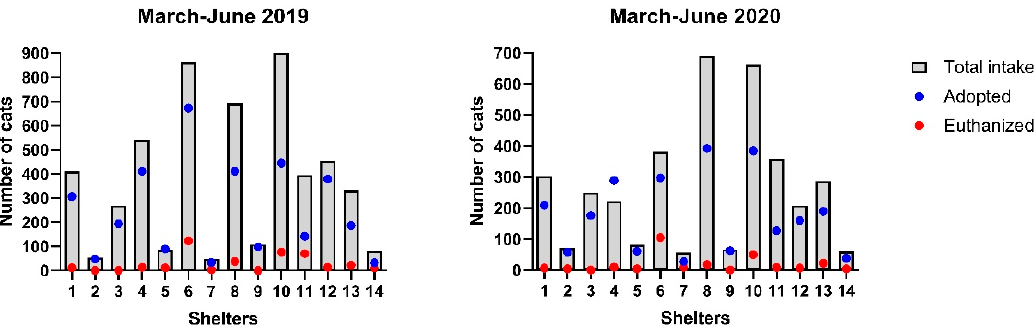
Figure 2. Cat intake, adoption, and euthanasia rates.